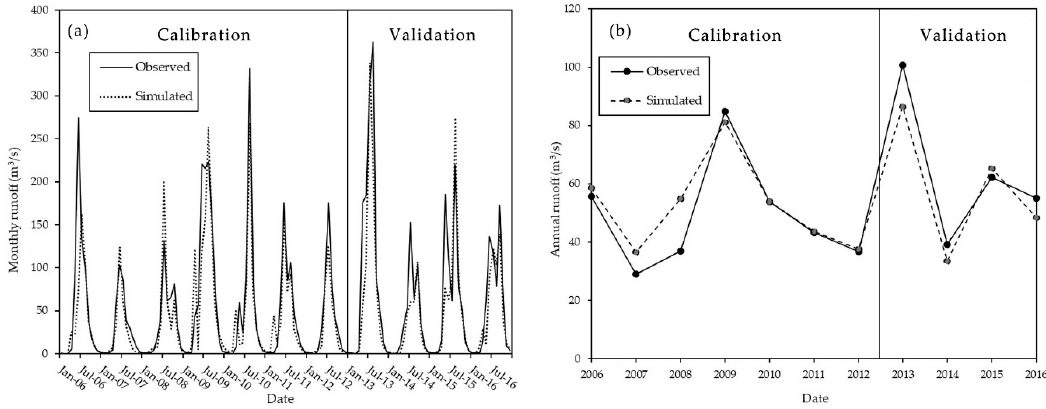
Figure 3. ( a ) Observed and simulated monthly runoff of the Tahe watershed during 2006–2016, ( b ) observed and simulated annual runoff of the Tahe watershed during 2006–2016. Table 2. Practicability evaluation of the SWAT model.